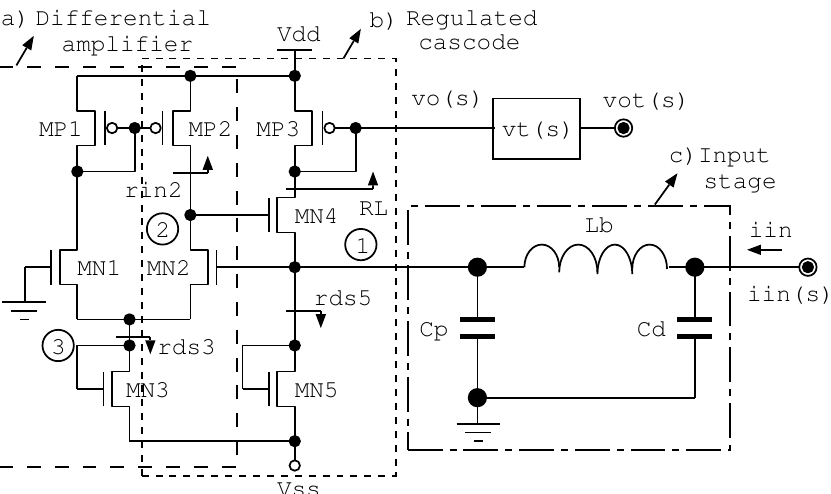
Figure 2. Schematic at the transistor level of the preamplifier stage. ( a ) differential amplifier; ( b ) regulated cascode; ( c ) input stage, including C d (diode capacitance), L b (wire bond inductance), and C p (parasitic capacitance of the pad). By the Kirchhoff’s voltage equations in nodes 0, 1, 2 and 3, the transimpedance transfer function is obtained.